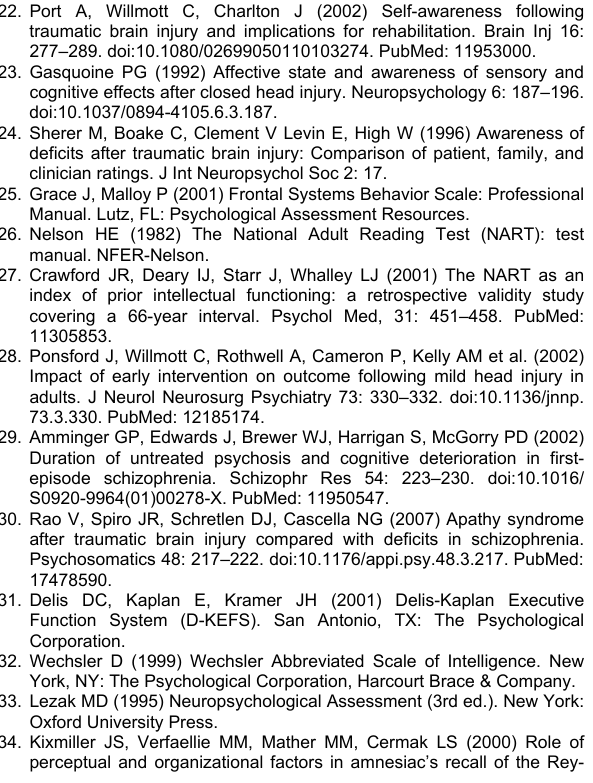
Osterrieth Complex Figure: A Comparison of three amnestiac groups. J